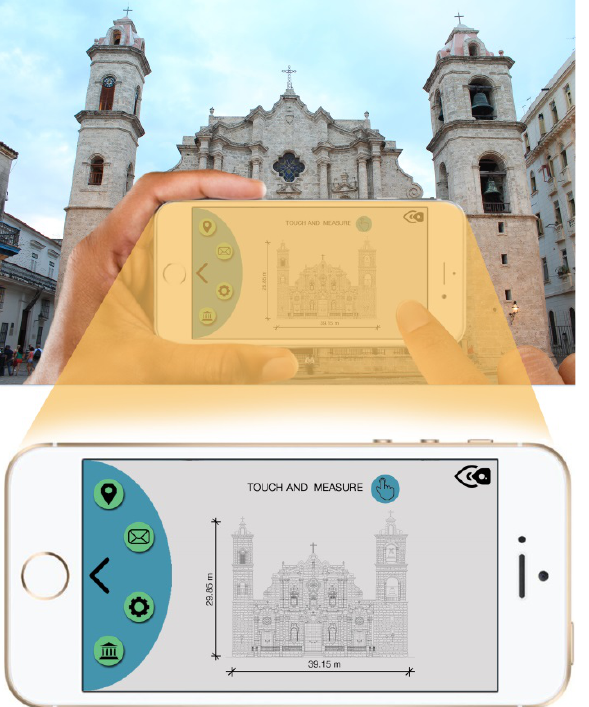
Figure 14. Example of an application of aumented reality (Catedral de la Virgen Maria de la Conceptión Inmaculada - Plaza de la Catedral)